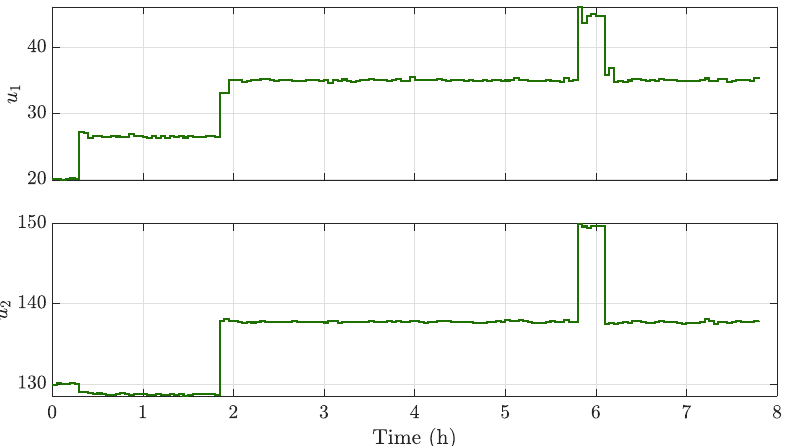
Figure 21. Case 1—Manipulated variables of the Van de Vusse reactor.